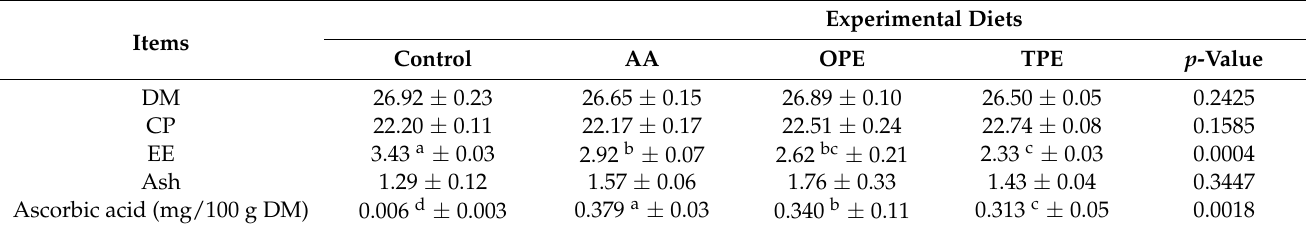
Table 5. Effect of dietary AA, OPE and TPE supplementation on the chemical composition of rabbits meat.